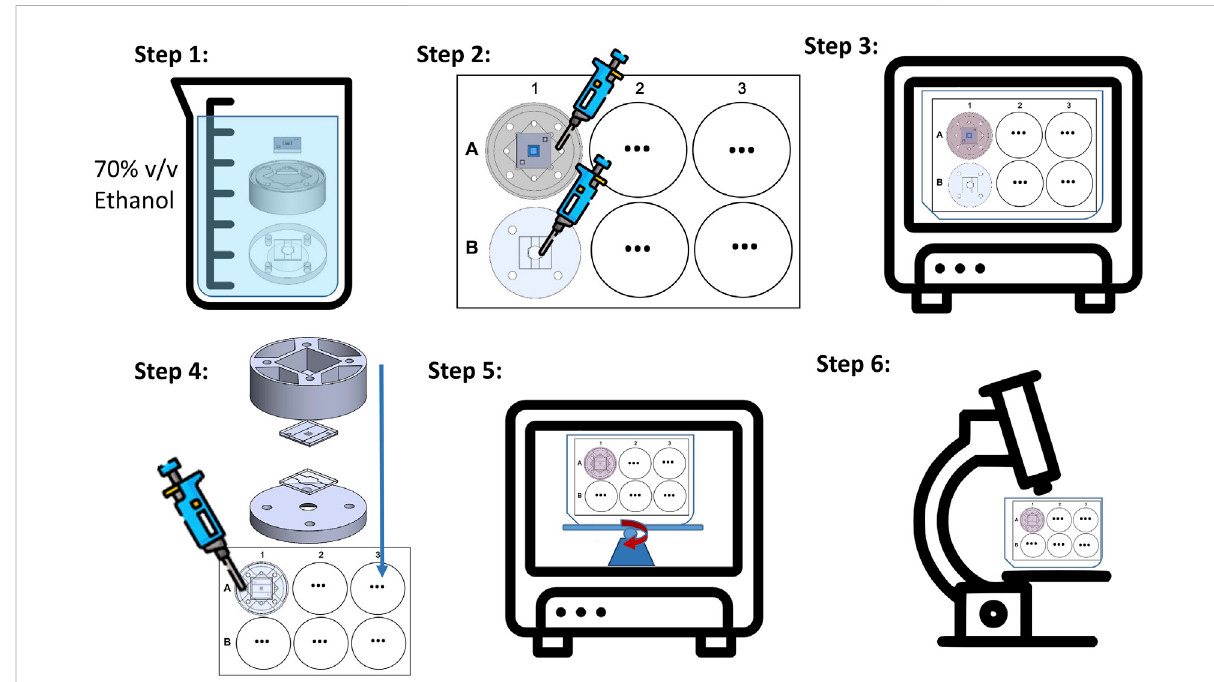
FIGURE 6 Schematic illustration of the on-chip cell cultivation protocol steps. Step 1: System decontamination including holder and chip. Step 2: Cell seeding with pipette through the holder reservoir into closed upper chip compartment (A) and cell seeding directly into the open cavity of the glass layer forming the lower chip compartment (B) . Step3: Pre-cultivation in the incubator. Step 4: System assembly with closure of the lower chip compartment. Step5: Long-termcultivationunderbi-directionalgravitydriven fl owinducedbytherockingplatform. Step6: Investigationofin the chip grown tissue under a light